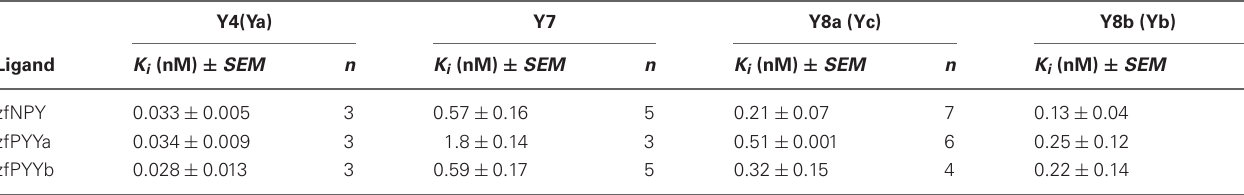
Table 2 | The K i values and standard error of the mean for four zebrafish receptors and their endogenous ligands.